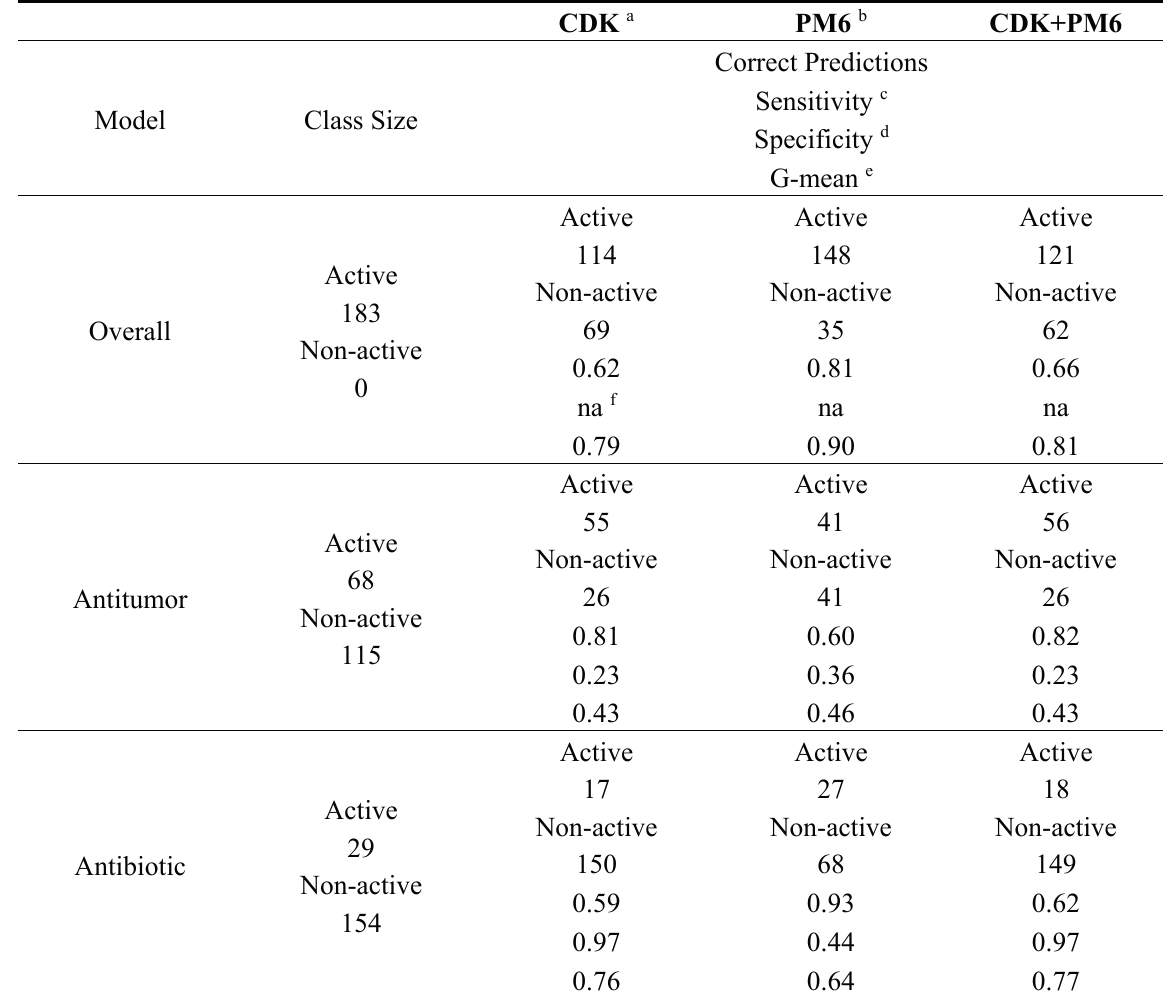
Table 4. Rfs predictions of the overall biological activity, antitumor and antibiotic activities for the test set